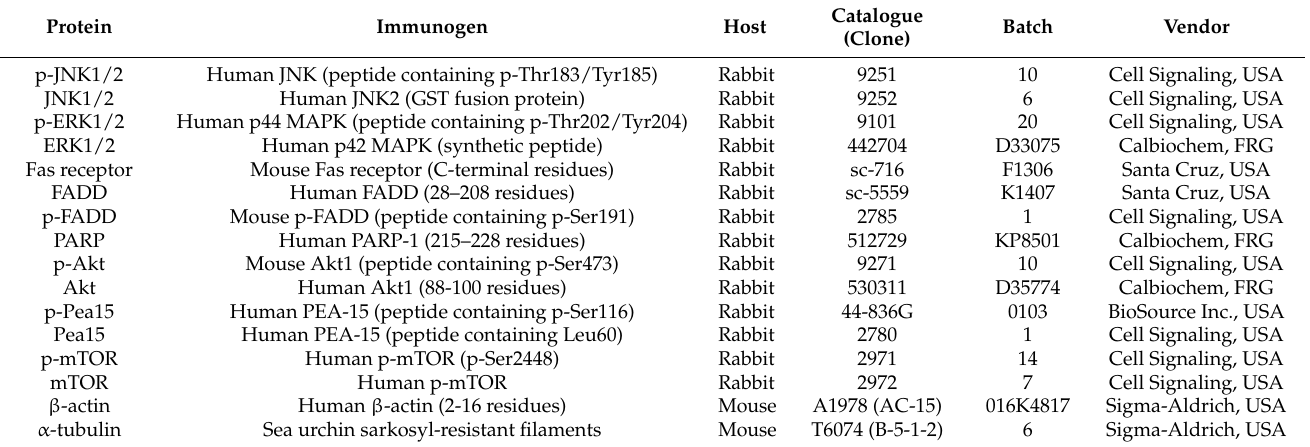
Table 2. Antibodies used for the detection and quantification of target